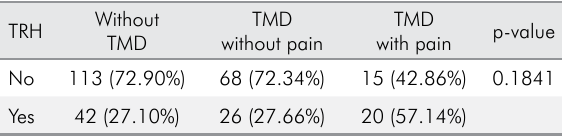
Table 1. Correlation between TRH use and signs of